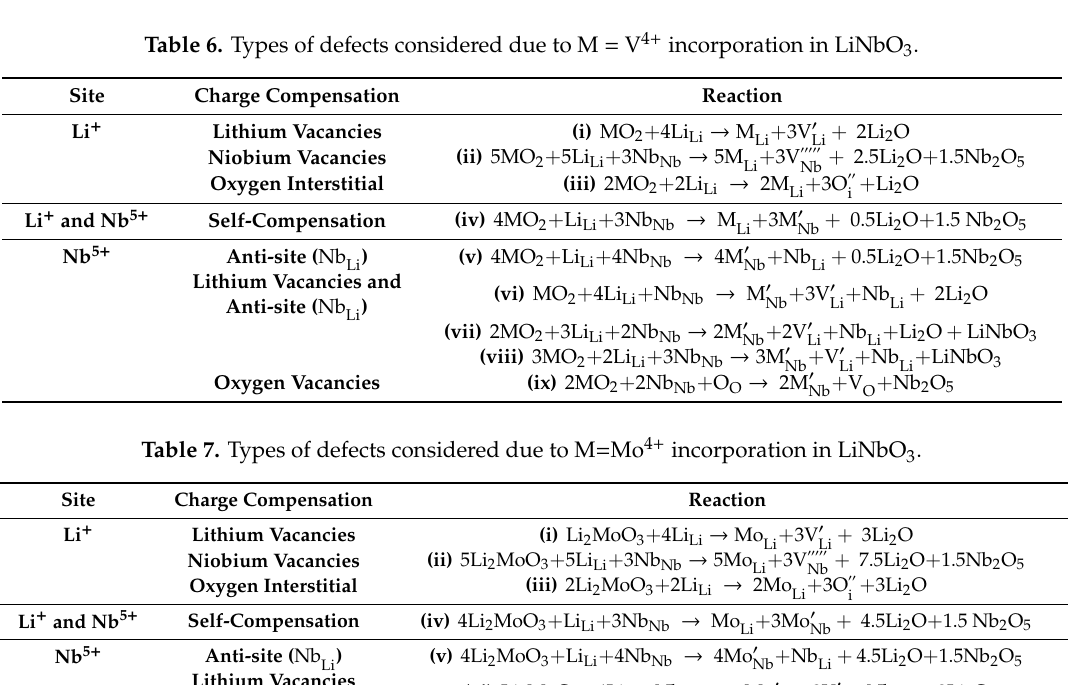
Figure 3. Bar chart of solution energies vs. solution schemes for trivalent dopant (Mo 3 + ) at the Li and Nb sites, considering the first neighbours in relation to the c axis.